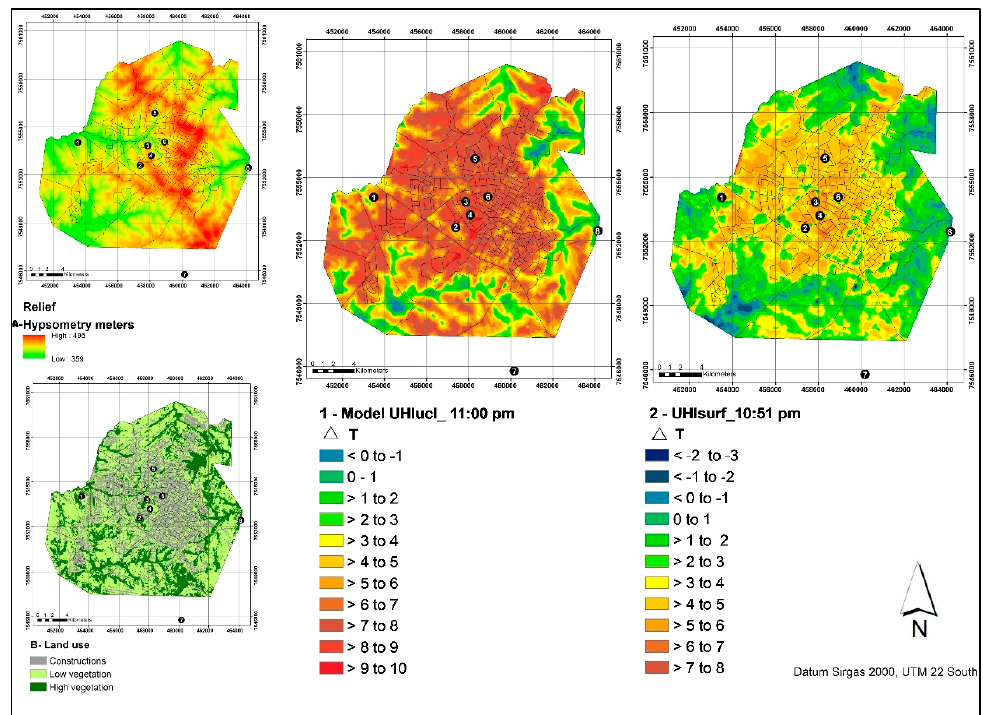
Figure 4. △ T of the modelgenerated UHI ucl (map 1) considering relief (detail A) and land use (detail B). △ T UHI surf map (map 2). Both referring to 10 May 2020, at 11:00 p.m. and 10:51 p.m. (local time), respectively, in Presidente Prudente city, Brazil. Source: USGS (2021); IBGE Census Bureau (2010). Elaborated by the authors (2022). Table 2. Results of data validation of the spatial model considering simple and multiple linear regression and significance tests with p -value ( α ≤ 0.05), as performed by ANOVA in Presidente Prudente,